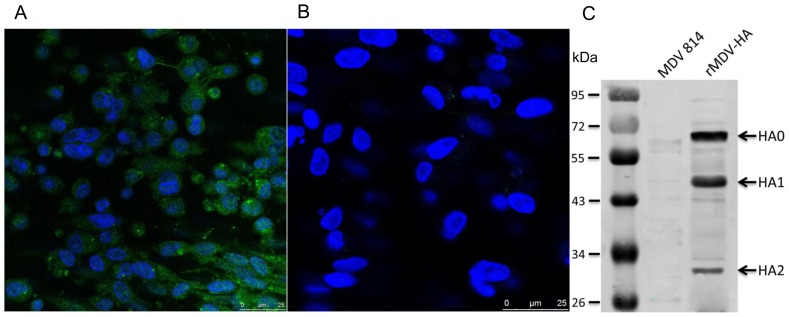
Immunofluorescence and Western blot analyses of recombinant HA protein expressed in rMDV-HA infected CEF cells.AIV-specific chicken serum antibodies bound to the rMDV-HA infected CEF cells (A) by indirect immunofluorescence, but not to the CEF cells infected with MDV 814 (B) 72 h post-infection. CEF cells infected with rMDV-HA and non-infected cells probed with an AIV-specific chicken serum and IRDye™ 800-labeled polyclonal rabbit anti-chicken IgG (1∶4000). HA-specific bands corresponding to the cleaved HA1 and HA2 were detected in preparations of rMDV- HA-infected cells by Western blot, but not in MDV 814 infected cells (C).